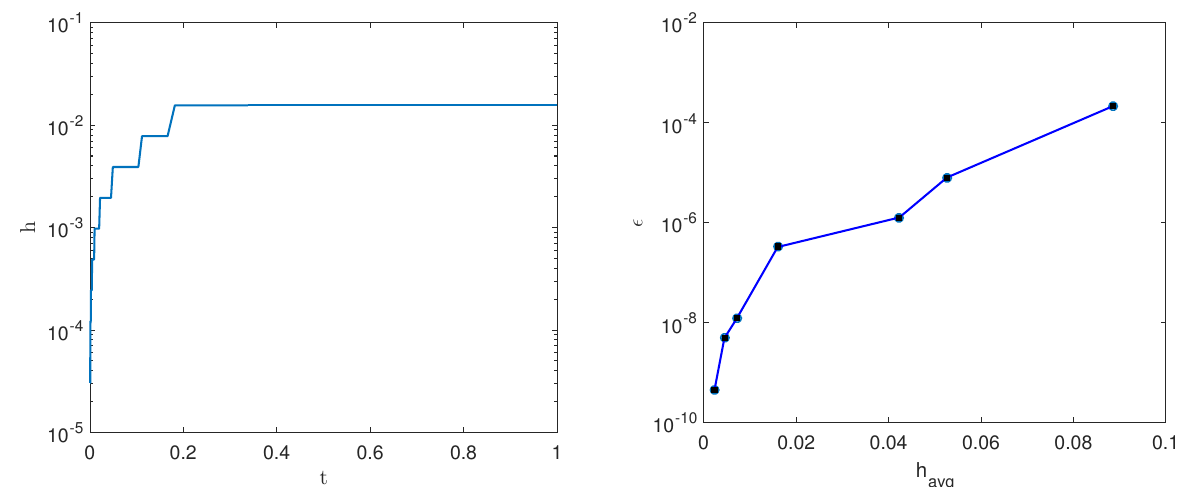
Figure 1. ( top left )—solution plot; ( top right )—accuracy vs. time; ( bottom left )—step-size vs. time; ( bottom right )—accuracy vs. h avg .